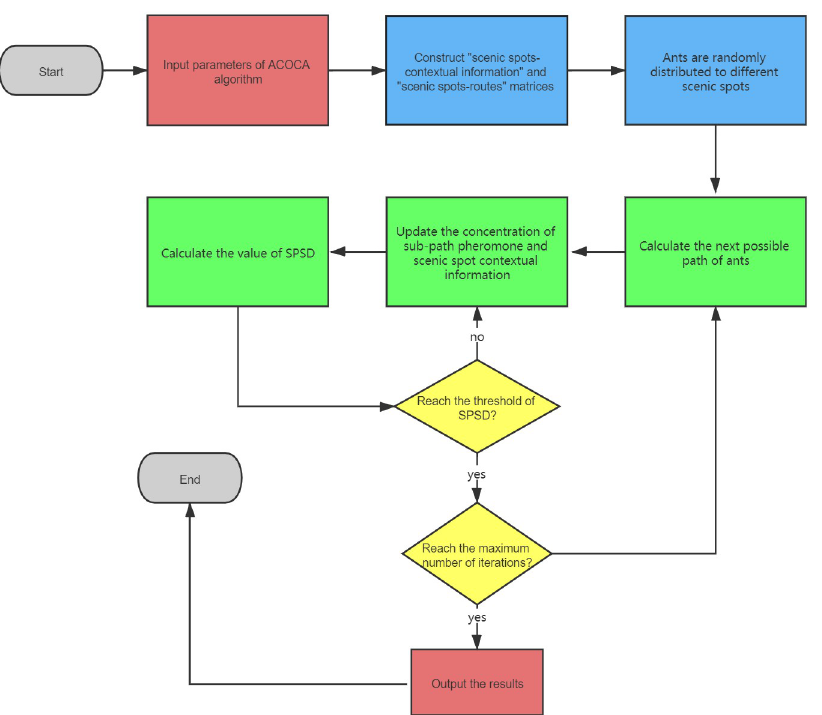
Fig 1. The workflow of ACOCA algorithm. Input: set the parameters of the algorithm, such as the number of ants, the maximum number of iterations, the initial comfort degree of each scenic spot, and the local optimal threshold x. Output: the optimal solution and its route set. Step 1: randomly put the ants in different scenic spots as the starting point; Step 2: each ant calculates the solution space and the comfort degree of each scenic spot; Step 3: calculates and updates the pheromone concentration on the connection path between scenic spots according to Eqs (5) and (9); Step 4: updates the comfort degree of the scenic spot every iteration; Step 5: judge whether the algorithm falls into